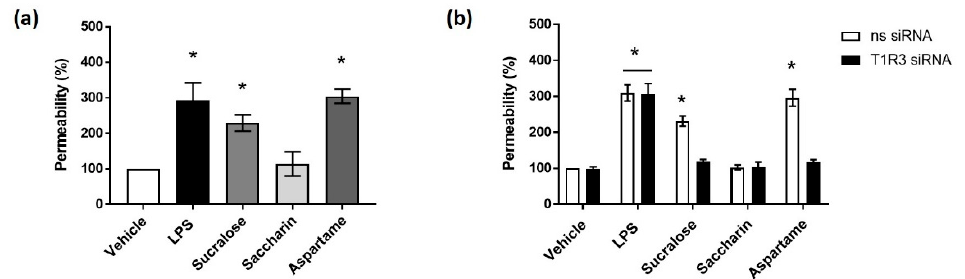
Figure 2. Low physiological concentrations of artificial sweeteners sucralose and aspartame disrupt the intestinal epithelial barrier through the sweet taste receptor. ( a ) The permeability of the epithelial monolayer was measured with an FITC-dextran assay, following exposure to sucralose, saccharin, and aspartame (0.1 mM) for 24 hours using lipopolysaccharide (LPS) (1 µg/ml) as a positive control. ( b ) The permeability of the Caco-2 cell monolayer was measured with an FITC-dextran assay following the siRNA knockdown of T1R3 for 24 hours and exposure to sucralose, saccharin, and aspartame (0.1 mM) for a further 24 hours. % permeability was calculated normalized to vehicle treatment. n = 6. Data are expressed as mean ± S.E.M. * p < 0.05 versus vehicle (0 µM).